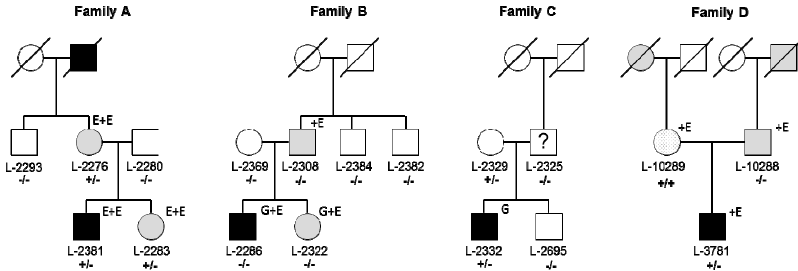
Figure 1. Pedigrees of four musician´s dystonia (MD) families. Black symbols represent individuals with MD, gray symbols mark individuals with WD, the dotted filled symbol indicates an individual with possibly mild, generalized dystonia, and the question mark points to an individual that was initially reported to have dystonia which however was not confirmed upon re-evaluation by two neurologists. L-2329 did not agree to be neurologically examined. A photograph of L-10289 illustrating her dystonic postures is shown in Figure S1. Patients of Family A were exome sequenced at Atlas Biolabs (superscript “E”) and three patients of Families B and C underwent genome sequencing at Complete Genomics (superscript “G”). Additional exome sequencing was performed for individuals of Families A, B, and D at Centogene (superscript“+E”). Mutational status for the p.Ile196Val mutation in RAB12 is indicated: +/+ for homozygous carriers; +/ − for heterozygous carriers; − / − for non-carriers. For individuals for whom DNA was available a sample ID number (L code) is shown. Dashed symbols represent deceased family